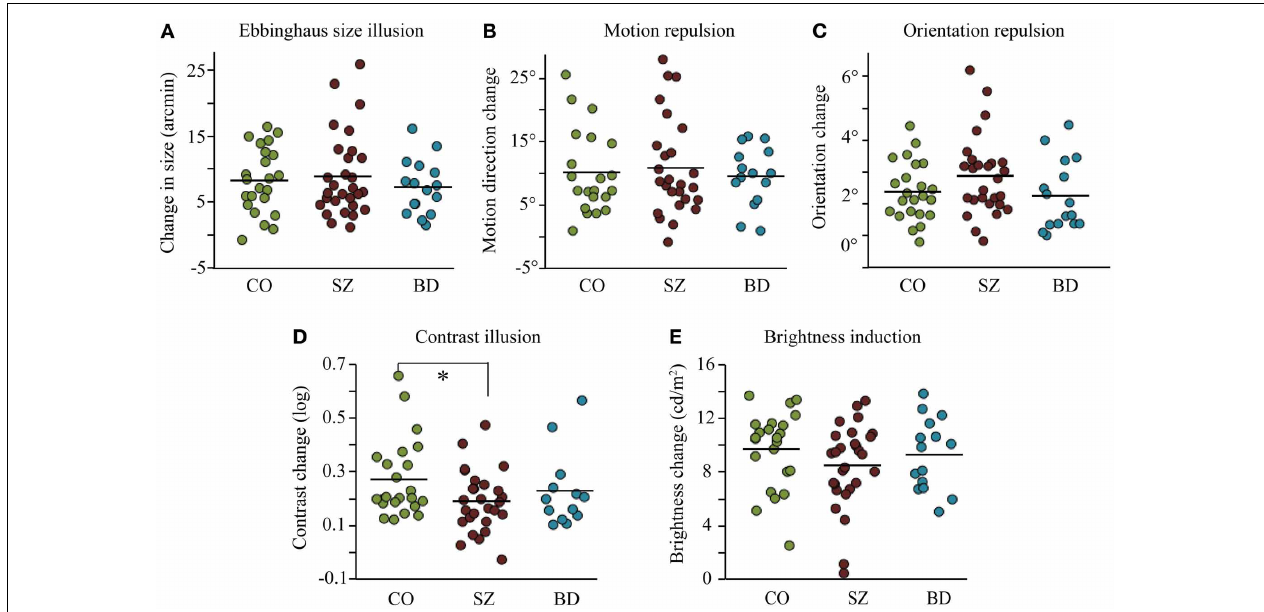
FIGURE 2 | Results from five context modulation experiments in individuals with schizophrenia (SZ), individuals with bipolar disorder (BD), and participants in the control group (CO): (A) Ebbinghaus size illusion, (B) motion repulsion, (C) orientation repulsion, (D) surround contrast illusion, and (E) brightness induction illusion (the condition